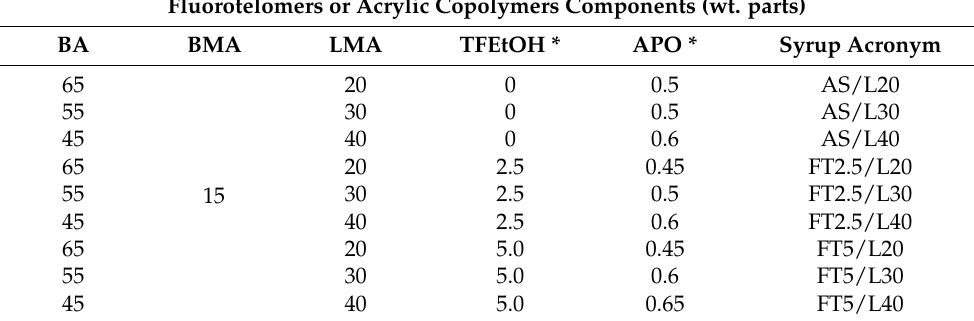
Table 1. Composition of acrylic copolymers and fluorotelomers syrups. Fluorotelomers or Acrylic Copolymers Components (wt.